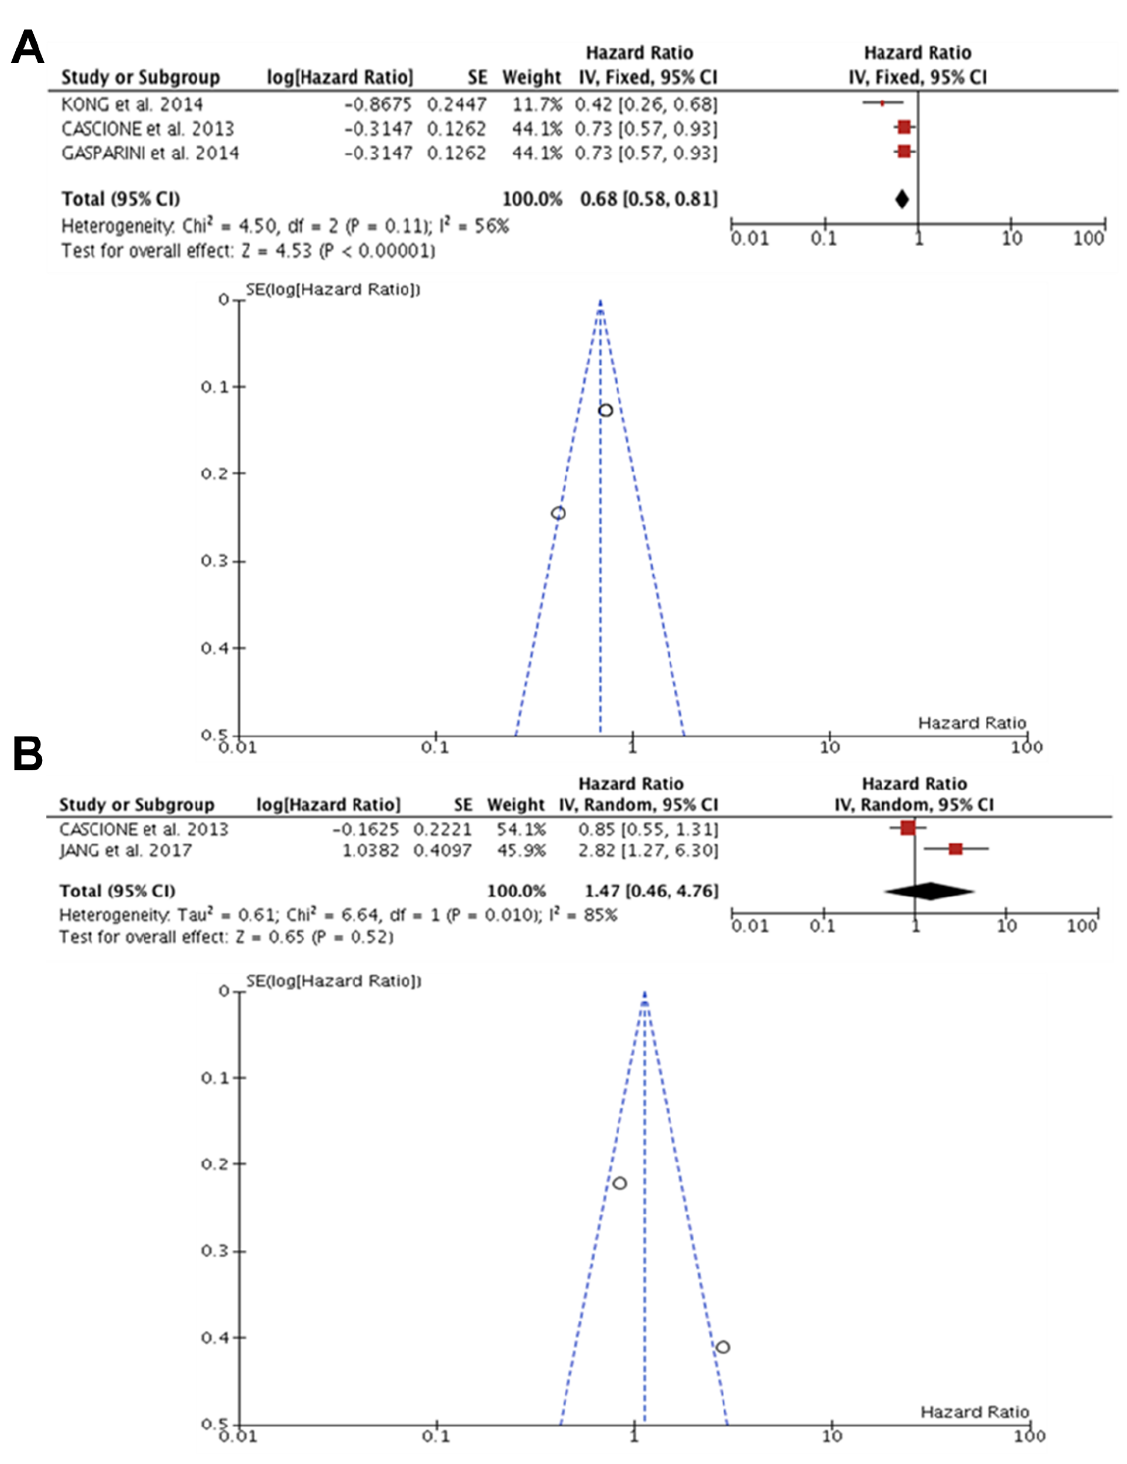
Figure 2. miR-155 and prognosis in TNBC. ( A ) Forest and funnel plot demonstrated miR-155 expression was associated with OS in patients with TNBC (HR: 0.68, 95% CI: 0.58–0.81, I 2 = 56%, p = 0.11), Z = 4, 53 ( p < 0.00001) [36,42,47]. ( B ) Forest and funnel plot showed miR-155 expression was not associated with DFS in patients with TNBC and in addition to significant heterogeneity (HR: 1.47; 95% CI: 0.46–4.76; I 2 = 85%, p = 0.010)